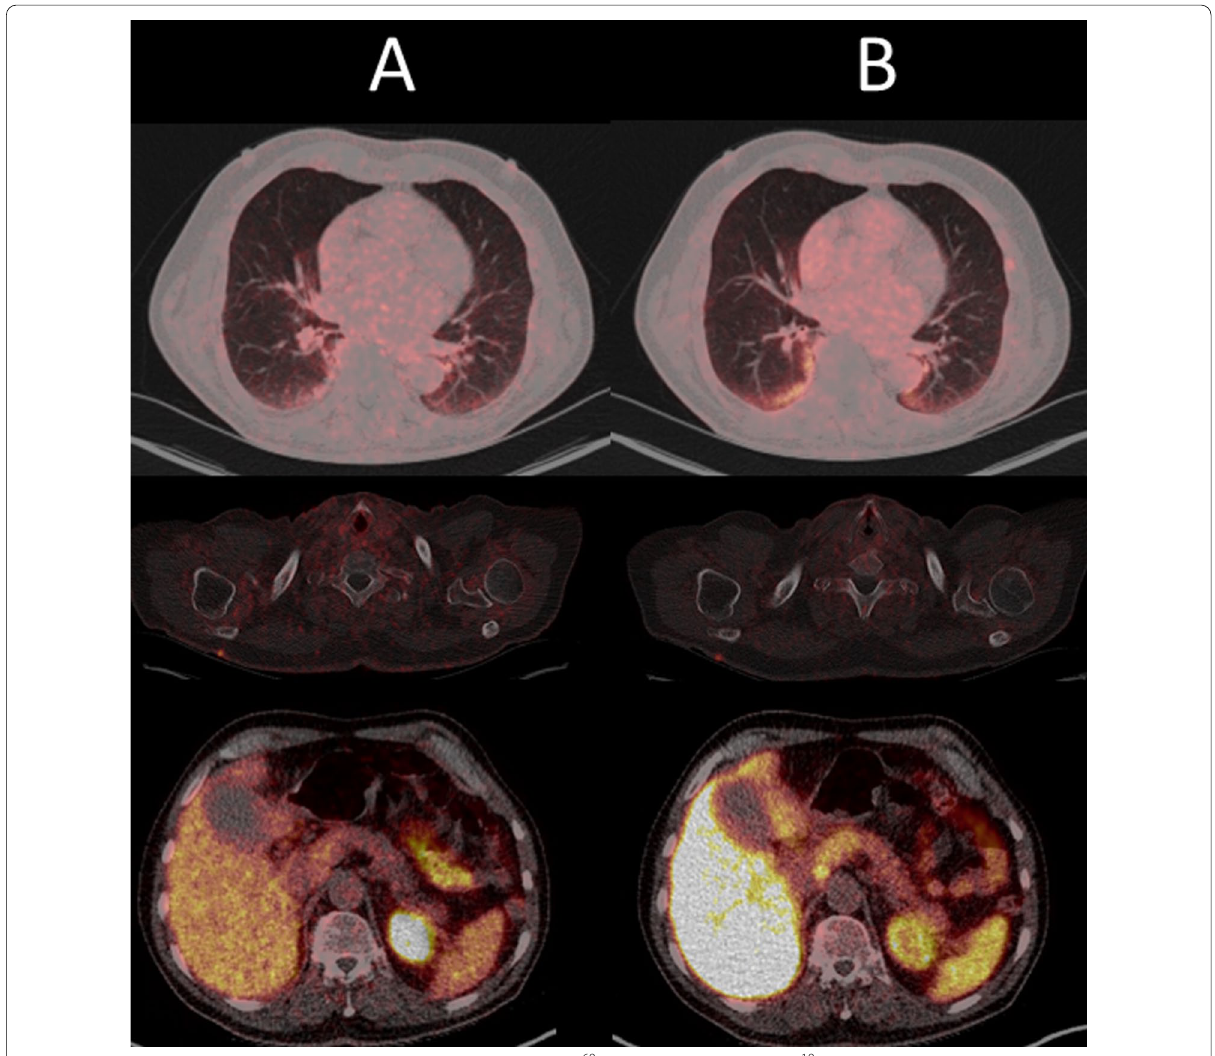
Fig. 10 Axial fused PET/CT with concordantly presumable unspecific [ 68 Ga]-Ga-PSMA-11 ( A ) and [ 18 F]-F-PSMA-1007 PET/CT ( B ) uptake in bipulmonary infiltrations, as well as in a cutaneous lesion in the right dorsal thoracic wall, clinically evaluated as keloid scar